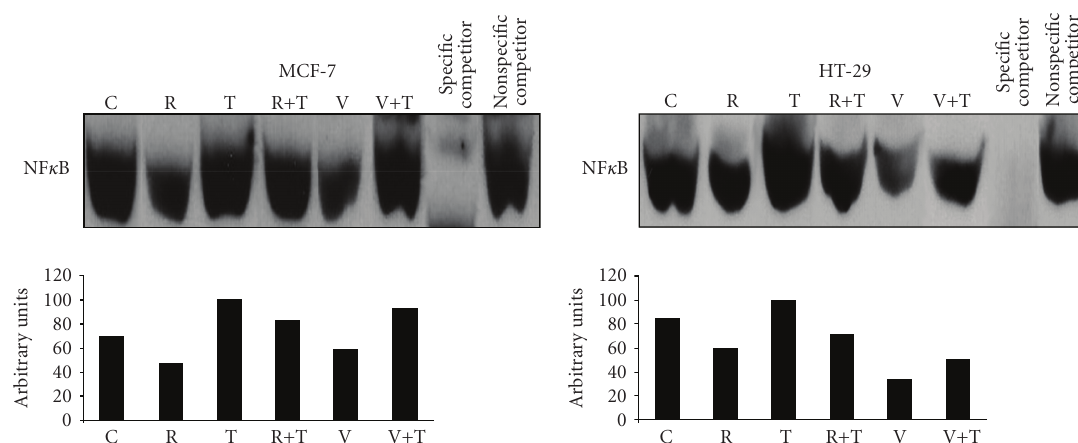
Figure 2: Rottlerin inhibits TNF α -induced NF- κ B/DNA binding activities in MCF-7 and HT-29 cells. Cells were pretreated with Rottlerin (20 μ M) or with Vitamin E (50 μ M) with subsequent stimulation with TNF α (10ng/mL) for 4hr. Nuclear extracts (20 μ g) were used to determine NF-B DNA binding activities by electrophoretic mobility shift assay (EMSA) using DIG-labled oligonucleotide containing NF κ B element. The unlabeled NF κ B consensus oligomer was used as the specific competitor and unlabeled NF-L6 consensus oligomer as the nonspecific competitor. Bottom panel shows the bands quantification of a representative blot. Complexes were visualized by chemiluminescence. Lanes: C, control; R, Rottlerin; T, TNF α ; R+T; Rottlerin and TNF α ; V, Vitamin E; V+T, Vitamin E and TNF α .